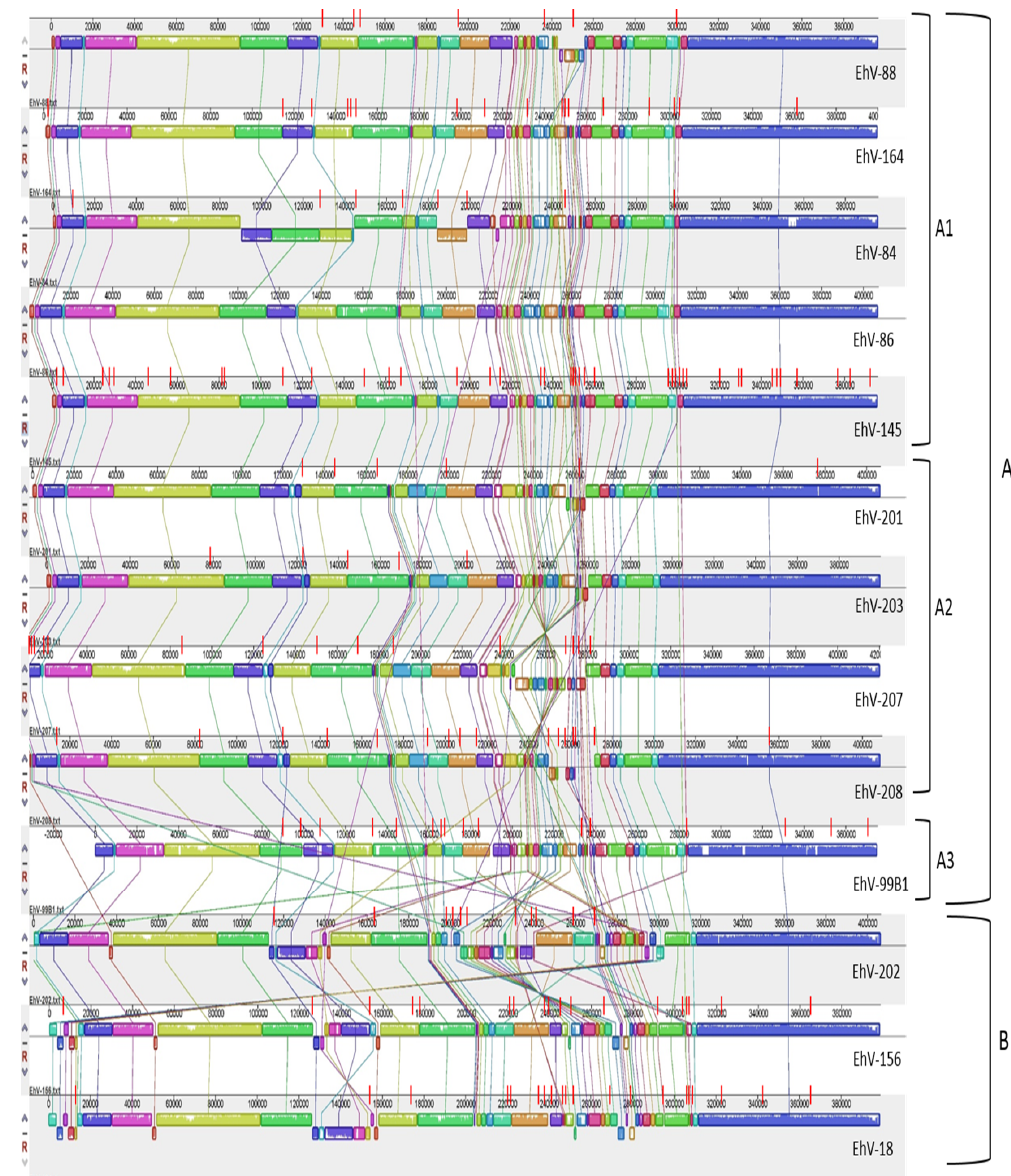
Figure 2. Whole genome alignment of sequenced coccolithovirus genomes. The genomes were aligned using MAUVE, in relation to the non ‐ gapped backbone genome of EhV ‐ 86. Syntenous blocks are indicated in the same colours and the lines that connect them indicate the position of each block in relation to the same block of genes in the genome of EhV ‐ 86. The small red lines on each genome represent the exact positions of the gaps that separate the different contigs within each draft genome. The genomes are ordered based on their DNA polymerase phylogeny (Figure 1), based on the ANI analysis of this study (Table 2), and based on previously published microarray data that puts them into the aforementioned groups and sub ‐ clades [20].